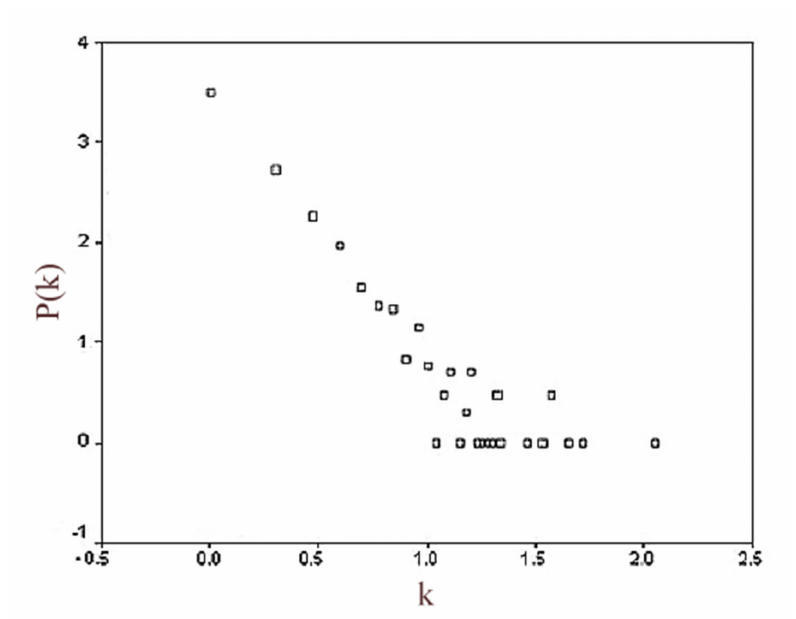
Figure 4. The Tokyo Industrial Park Ohta—Ward SCN degree distribution.